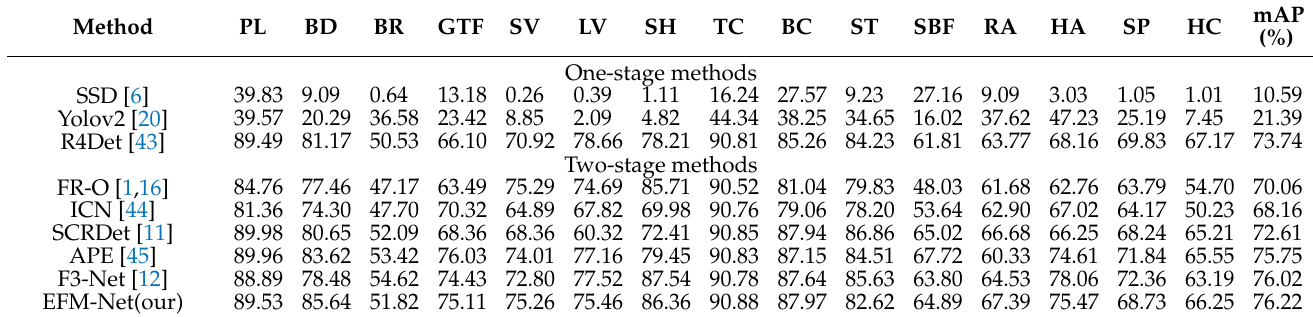
Table 2. Performance evaluation of the OBB task on the DOTA dataset.